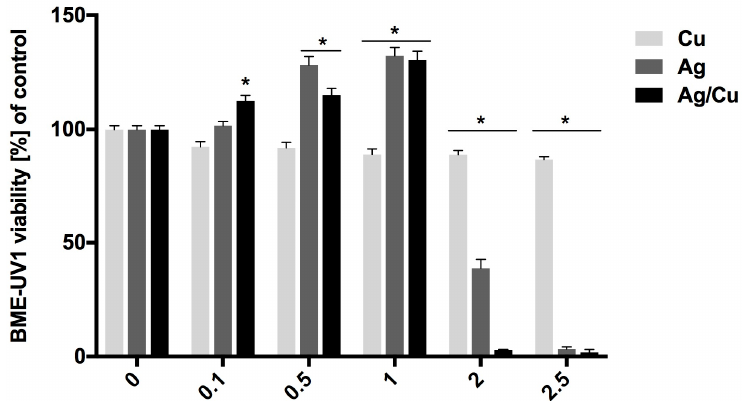
Figure 1. Oxidoreductive activity of BME-UV1 cells, calculated using PrestoBlue test (*—differences significant at p ≤ 0.05).